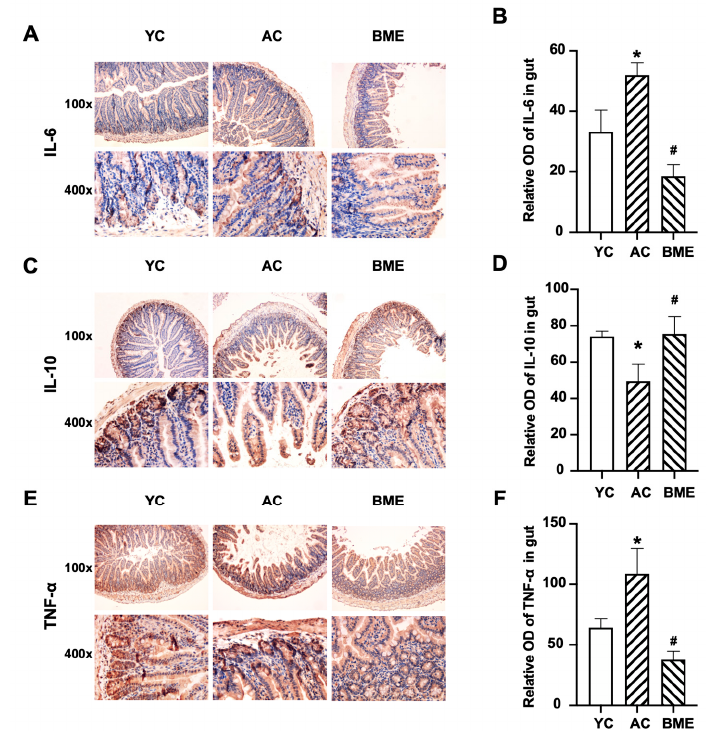
Figure 4. Immunohistochemical staining and optical density (OD) values of cytokines in mouse in- testines. Representative micrographs of ( A ) IL-6, ( C ) IL-10, and ( E ) TNF- α immunostaining visualized with DAB and counterstained with hematoxylin. Integrated OD values of ( B ) IL-6, ( D ) IL-10, and ( F ) TNF- α were used to analyze the results of the immunohistochemistry. All results are expressed as means ± SEMs ( n = 3). * p < 0.05 versus YC group, # p < 0.05 versus AC group. AC: aged control, BME: blueberry–mulberry extract, YC: young control.